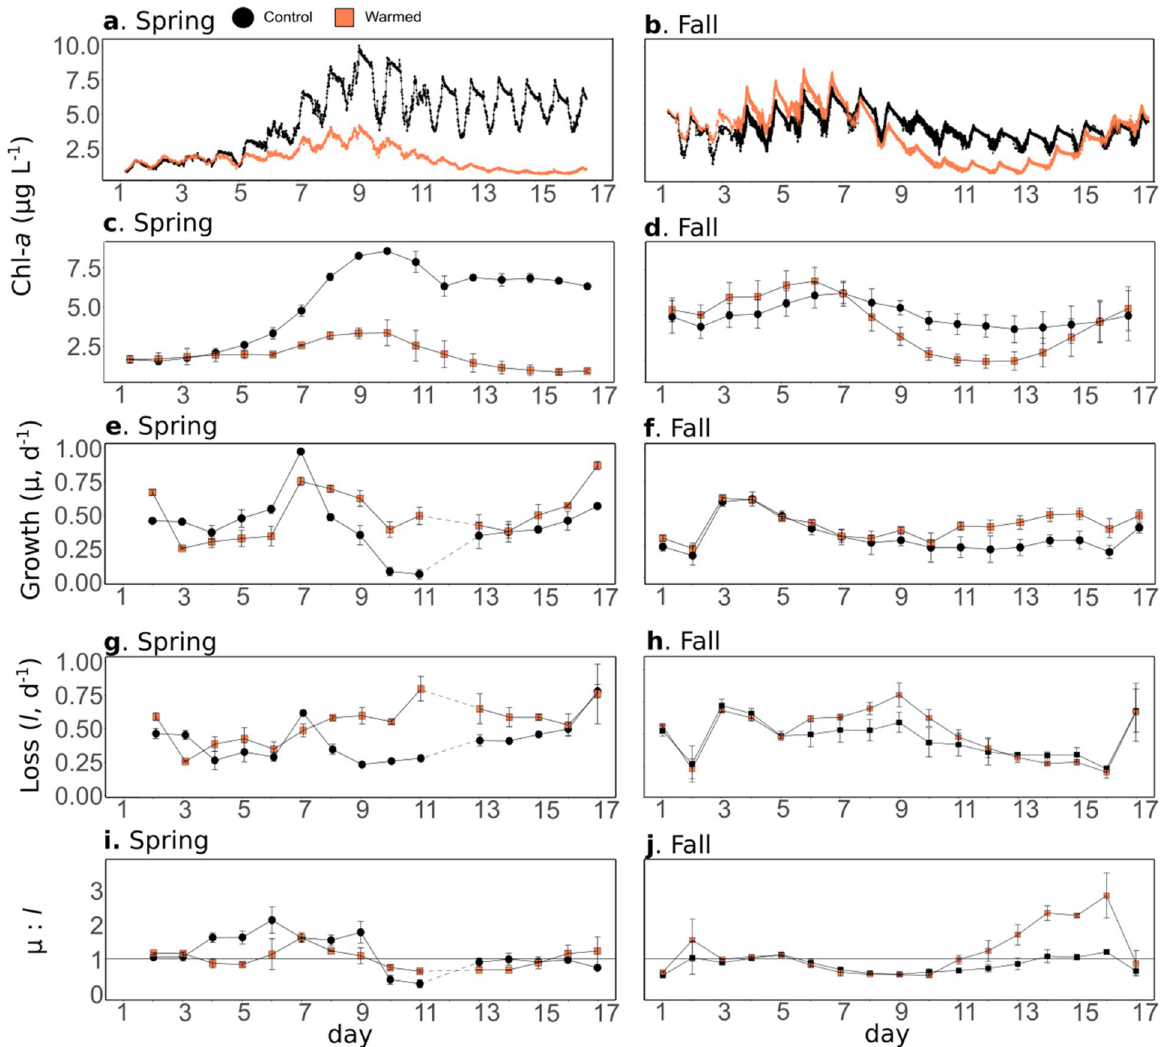
Figure 3. Phytoplankton chlorophyll- a , growth and loss rates. High-frequency chlorophyll- a data, uncorrected for Non Photochemical Quenching (NPQ) ( a , b ), daily average chlorophyll- a data corrected for the NPQ( c , d ), phytoplankton growth rate (µ, e , f ), loss rate ( l , g , h ), and µ: l ratio ( i , j ) in the control (black) and warmed (orange) treatments. Error bars represent range of observation for the two mesocosms per treatment in spring and the standard deviation for the three mesocosms per treatment in fall. In the spring experiment, µ and l could not be estimated on d1 and d12 and, for the latter, the missing data are represented as dotted